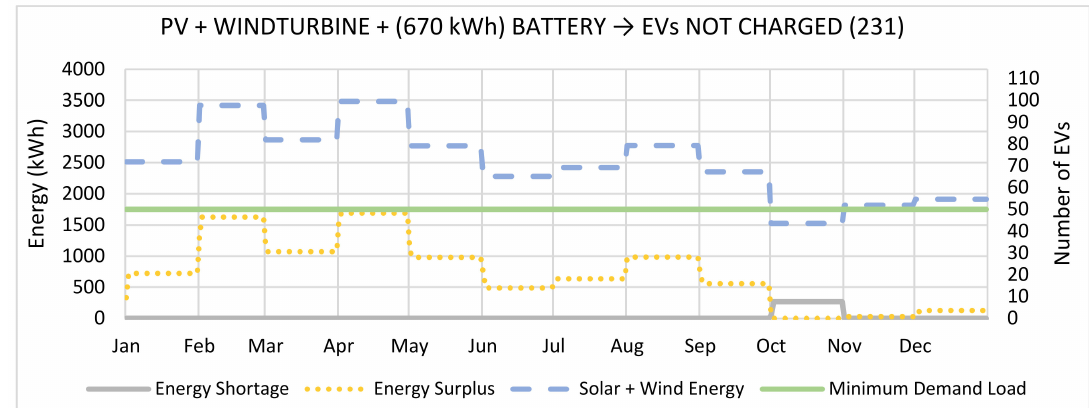
Figure 10. PV, WT and selected BSS size annual simulation results.